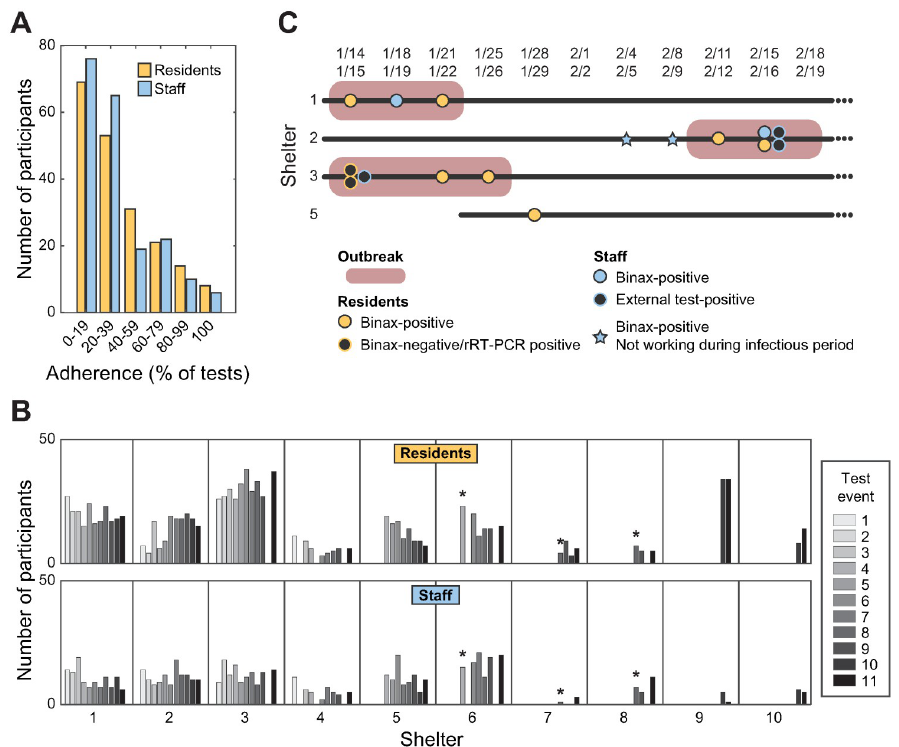
Fig 2. Participation in rapid SARS-CoV2 antigen testing and positive cases over time at homeless shelters, San Francisco, 2021. A) Histogram of adherence (percentage of tests taken by a participant from tests available to them; n = 394, within 6 shelters with 6 or more testing events). B) Number of participants over testing events per shelter. Missing bars indicate no testing event in that date. Shelters 5–10 were added to the BinaxNOW Testing Pilot after the start of the study period. � : Scheduled testing times were modified after indicated event. C) 3 outbreaks and 1 isolated BinaxNOW-positive case were identified. All outbreaks were resolved. No cases were identified in the other 6 shelters during the study